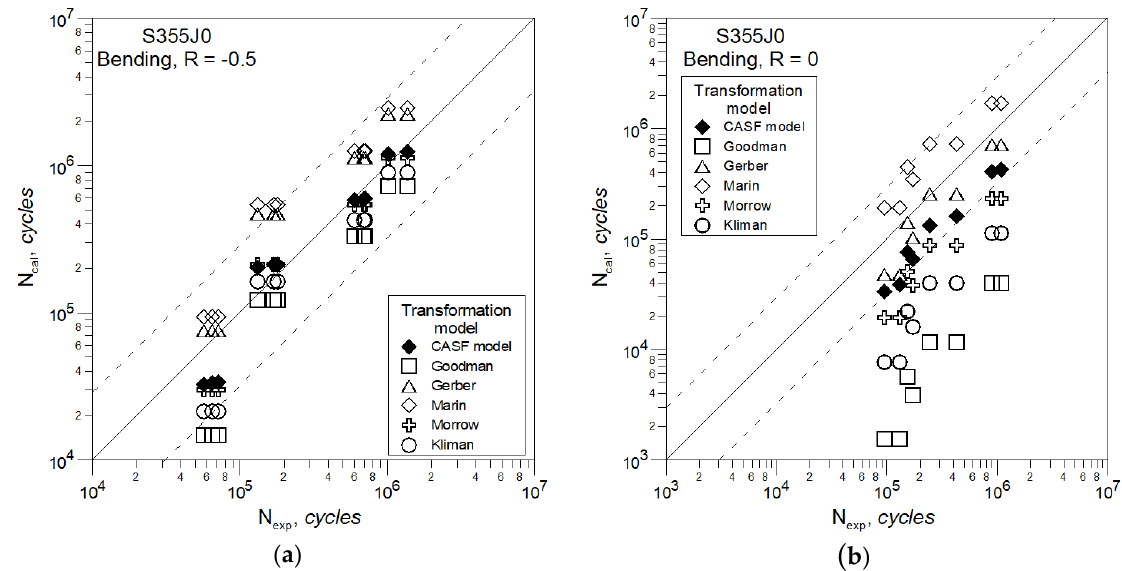
Figure 8. Comparison of the computational life N cal with the experimental N exp under bending for: ( a ) R = −0.5, ( b ) R = −0.